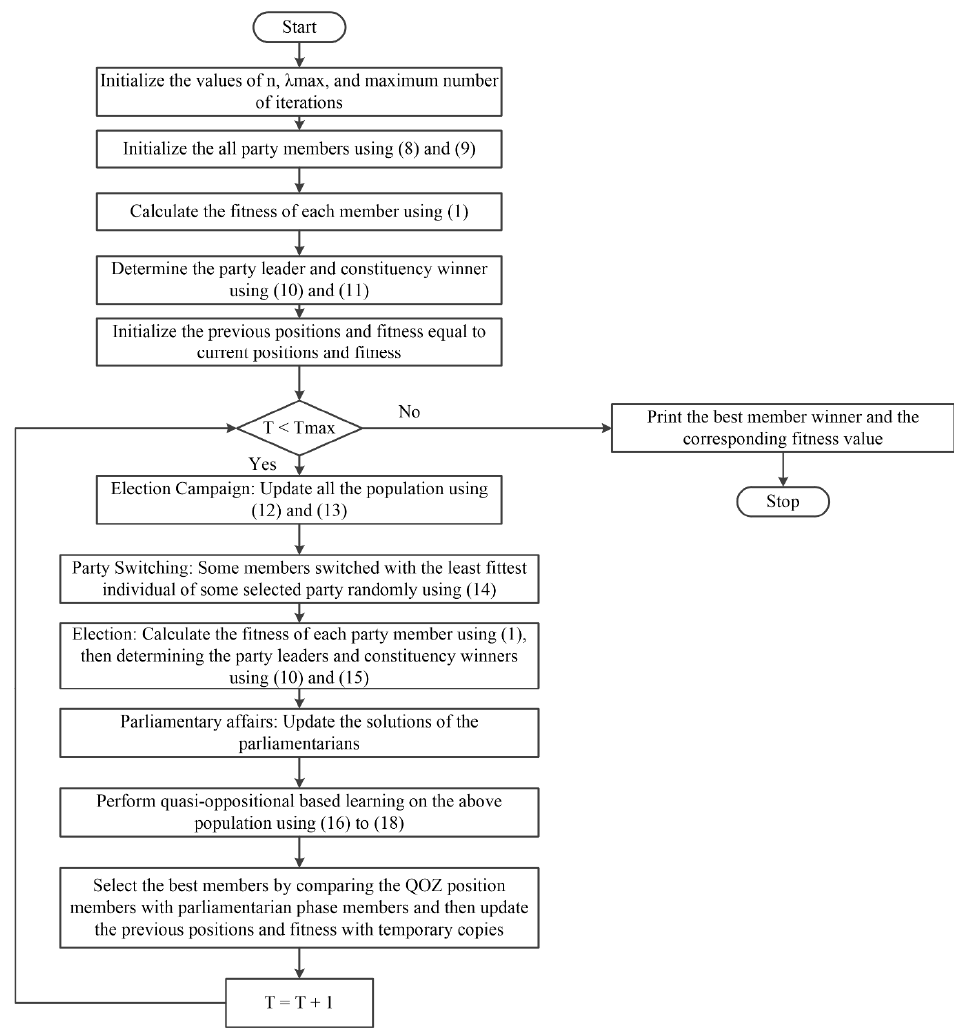
Figure 1. Flow chart of proposed QOPO technique.